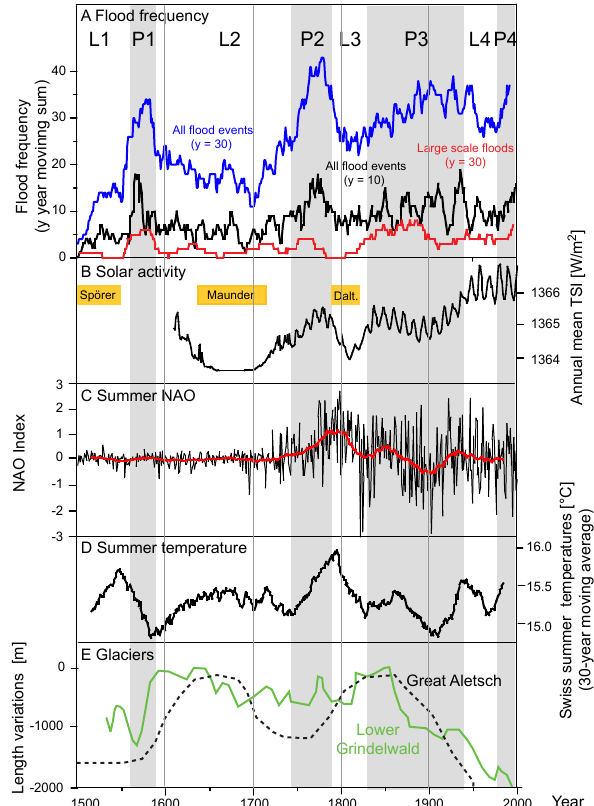
Fig. 5. Frequency of flood events in the 14 Swiss catchments and catastrophic events throughout Switzerland. P1–P4 are periods with many floods and L1–L4 with few floods in northern Switzer- land (A) . Also shown are the Sp¨orer, Maunder and Dalton peri- ods of low solar activity and the total solar irradiance TSI from Lean (2004) (B) . The reconstructed yearly summer NAO values (black) and the 30-year moving average (red) are from Luterbacher et al. (1999 and 2002a) (C) , the reconstructed Swiss summer tem- peratures (D) are from Casty et al. (2005) and the advances and retreats of the Lower Grindelwald and the Great Aletsch glacier are from Holzhauser and Zumb¨uhl (1999) (E)